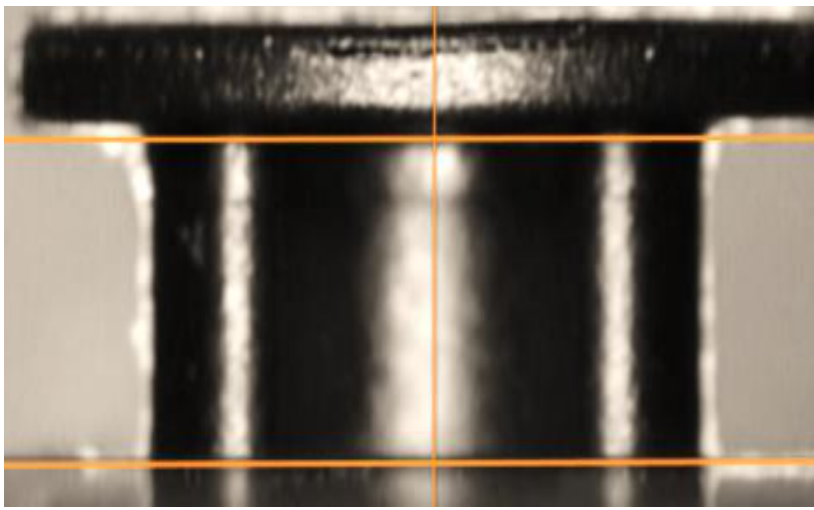
Figure 4. Checking the dimensions and geometry of the parts.